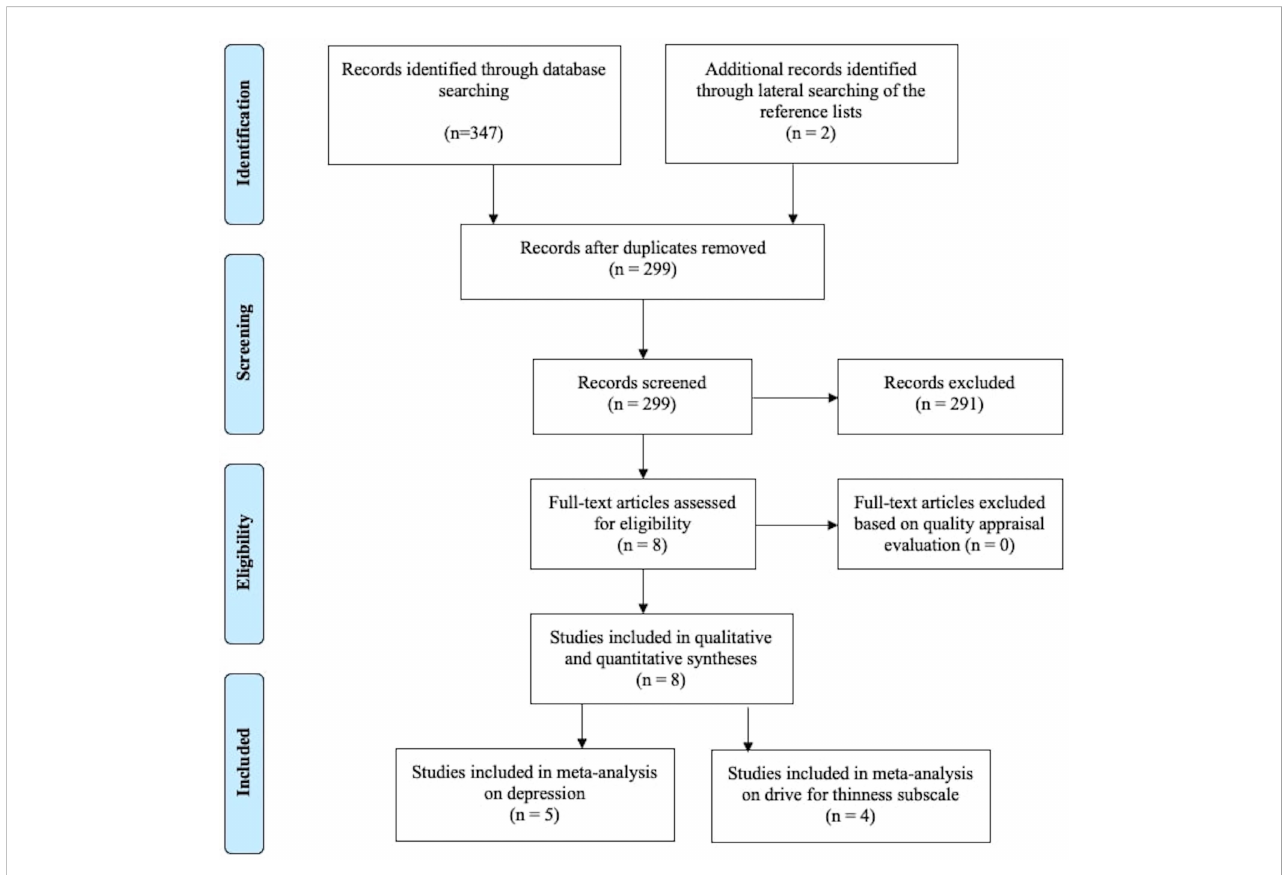
FIGURE 1 Flow diagram of literature search and process of studies ’